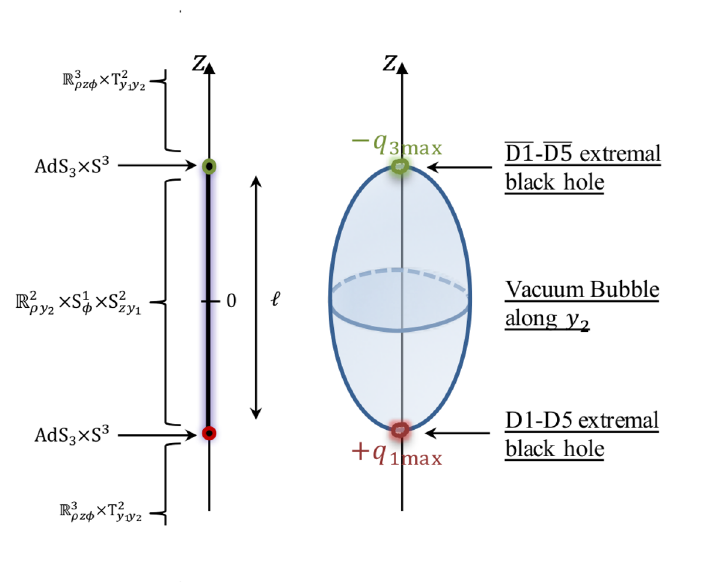
Figure 7 . Profile of the sources and topology on the z -axis for a bound state of D1-D5 branes and D1-D5 anti-branes separated by a bolt. Such solutions correspond to two extremal D1-D5 black holes of opposite sign of charges hold apart by a vacuum